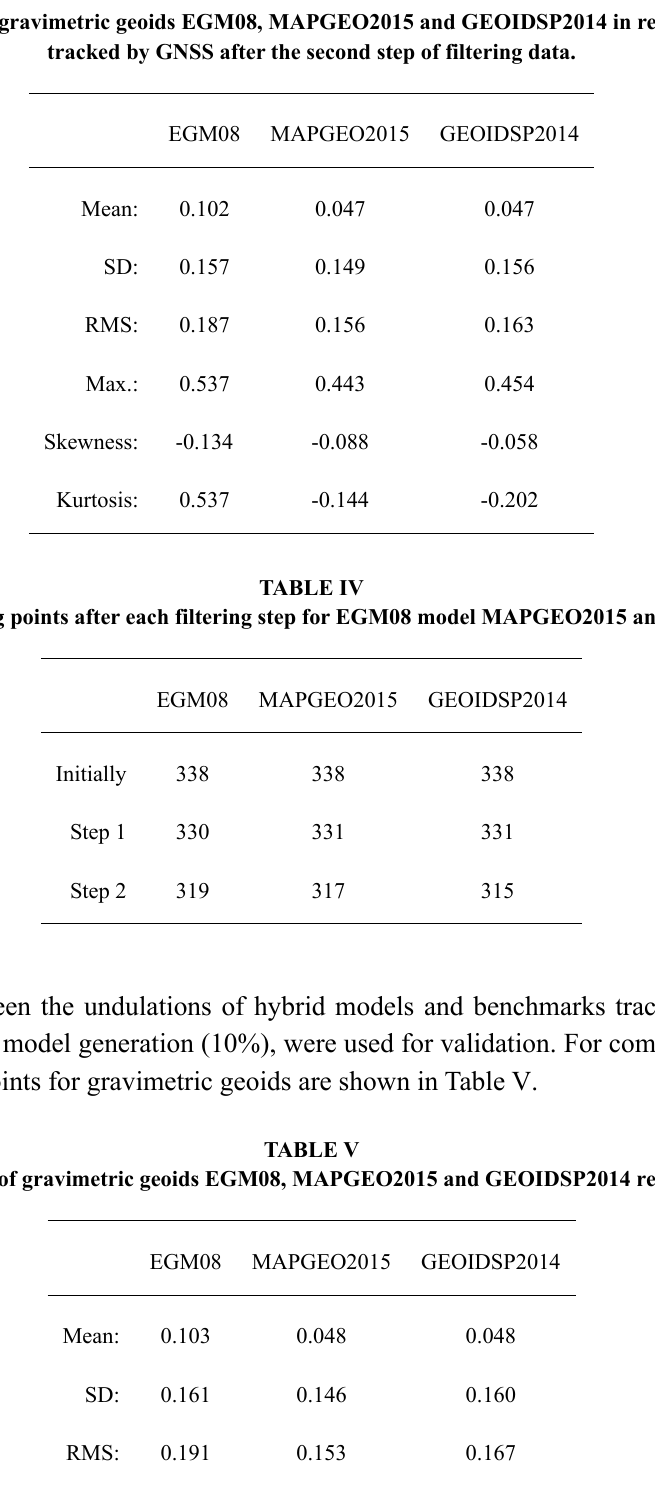
Consistency (in meters) of gravimetric geoids EGM08, MAPGEO2015 and GEOIDSP2014 in relation to leveling points